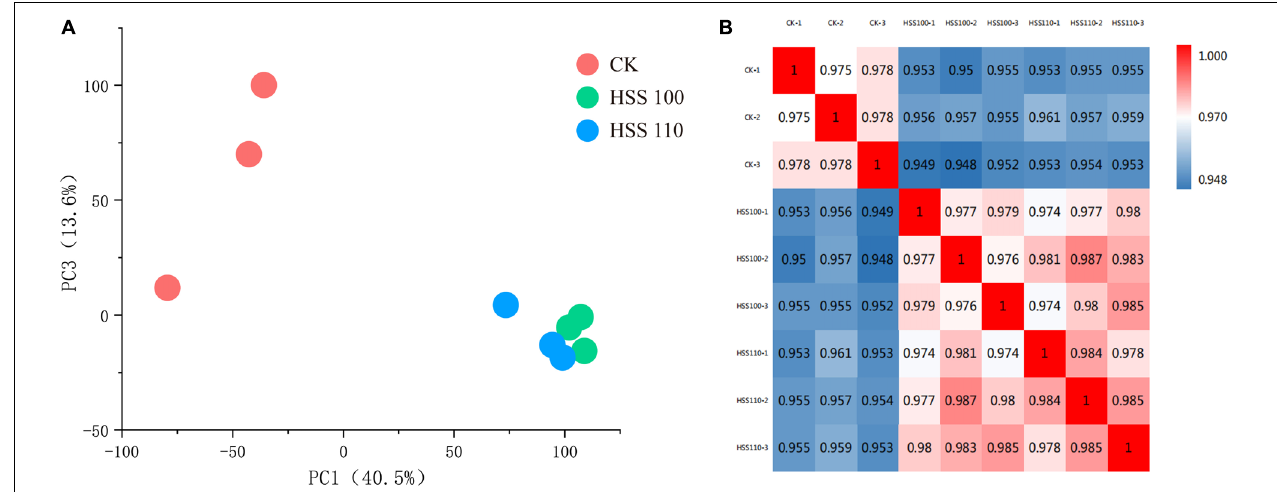
FIGURE 1 | Results of the DIA analysis of P. haitanensis exposed to hypersaline stress for 4 h. (A) Principal component analysis of each sample. (B) Heat map presenting sample correlations.